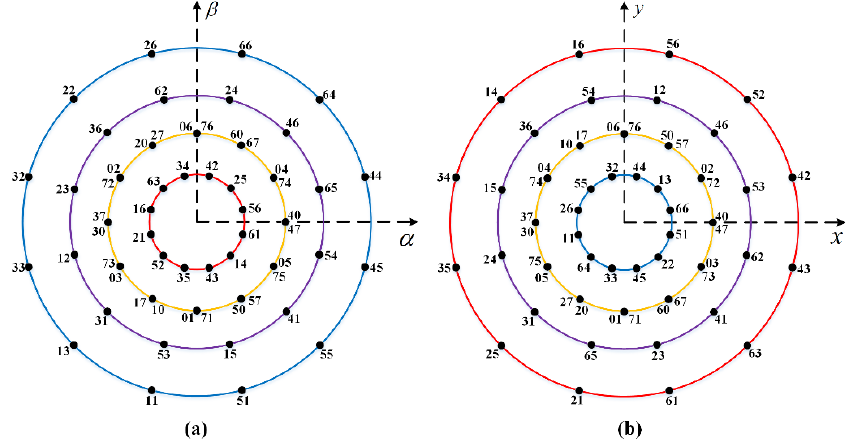
Figure 2. Voltage vectors in two subspaces. ( a ) α - β ; ( b ) x-y .